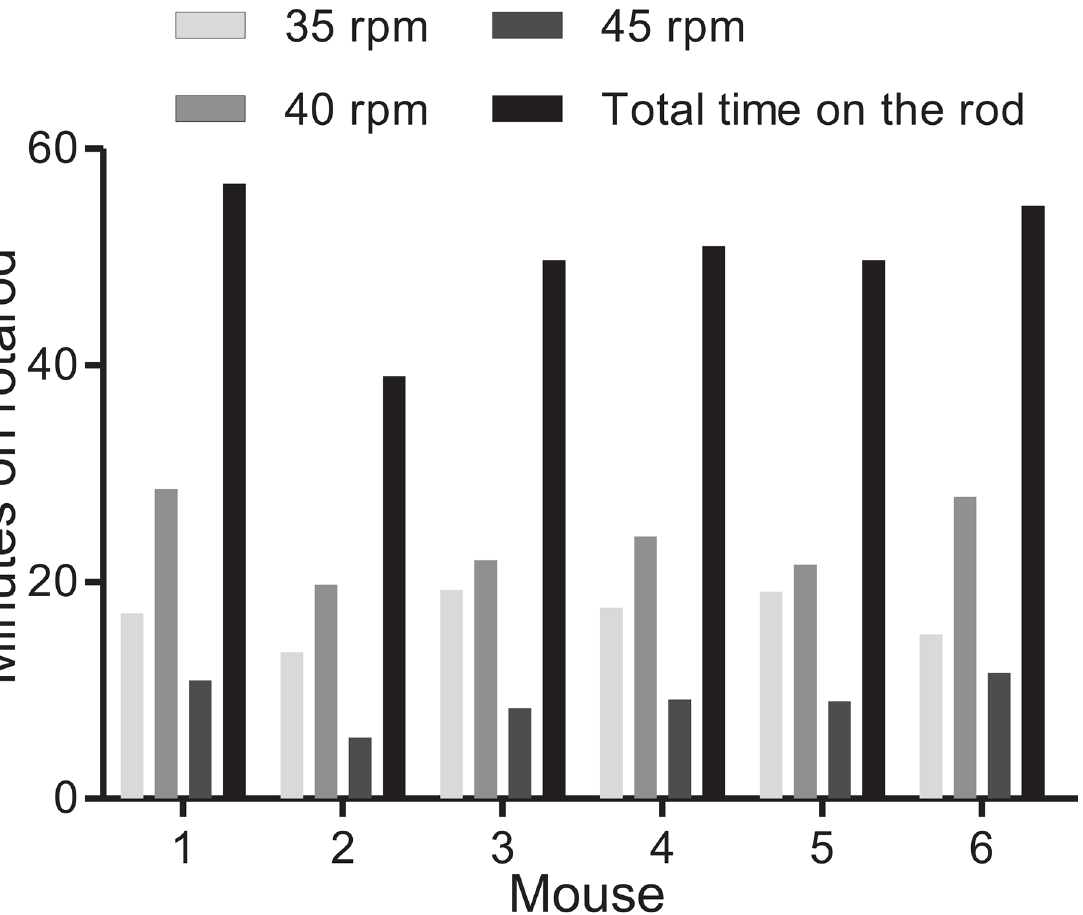
Fig 1. Mouse exercise session on a rotarod. After initial training, individual mice were run on an increasing rotarod speed of 35, 40, and 45 rpm. Graph shows time spent at each speed and cumulative time, in minutes, for each